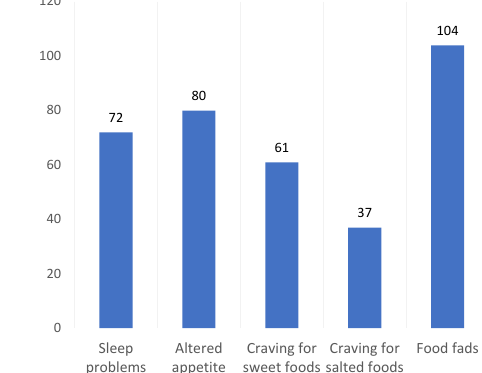
Figure 2 . Physiological Problems Reported by Explorers at Extreme-Altitude (Vertical axis depicts the number of